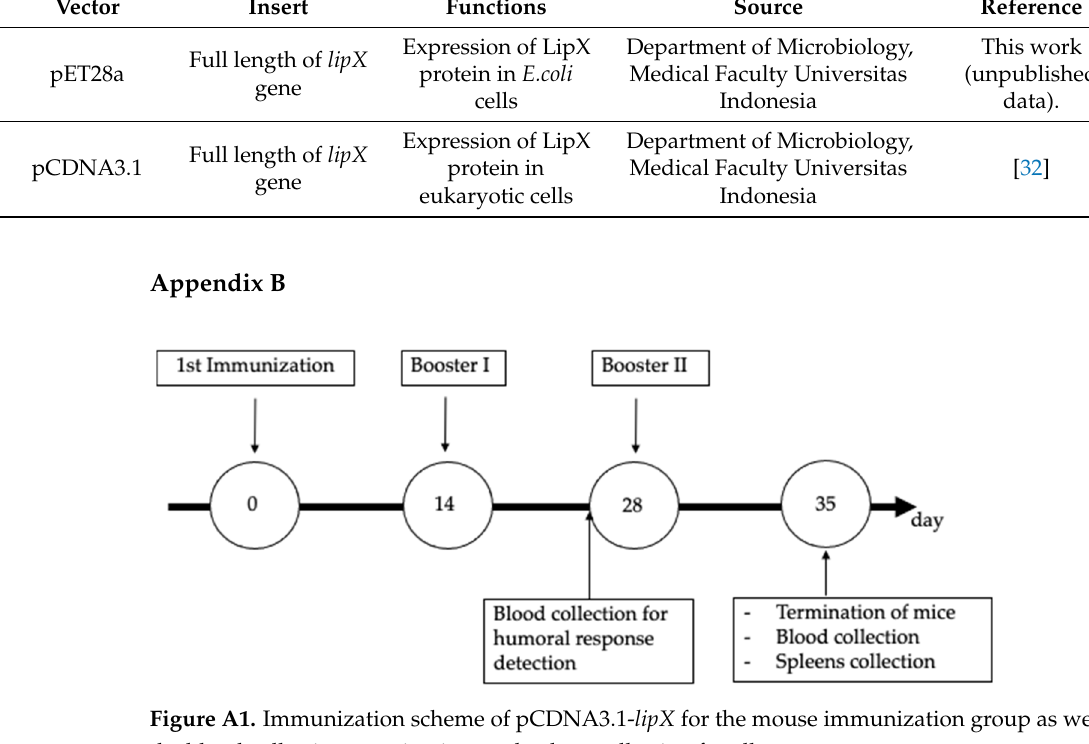
Table A1. Recombinant plasmids used in this research.